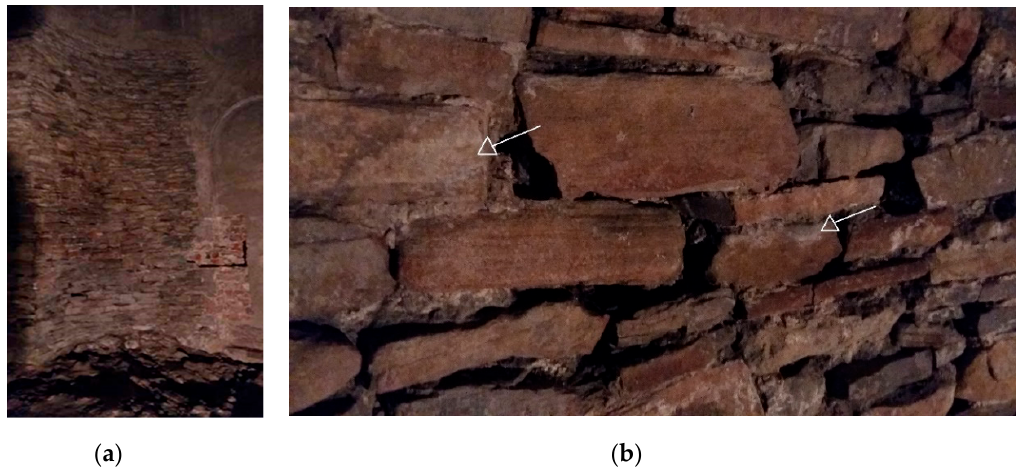
Figure 1. An internal wall of Sts. Felix and Adauctus Rotunda: ( a ) General view of the highest preserved wall part; ( b ) Zoomed view of the structure of irregular sandstone plate bound with lime mortar. Numerous cavities and crevices as well as efflorescence are clearly visible (marked by arrows).